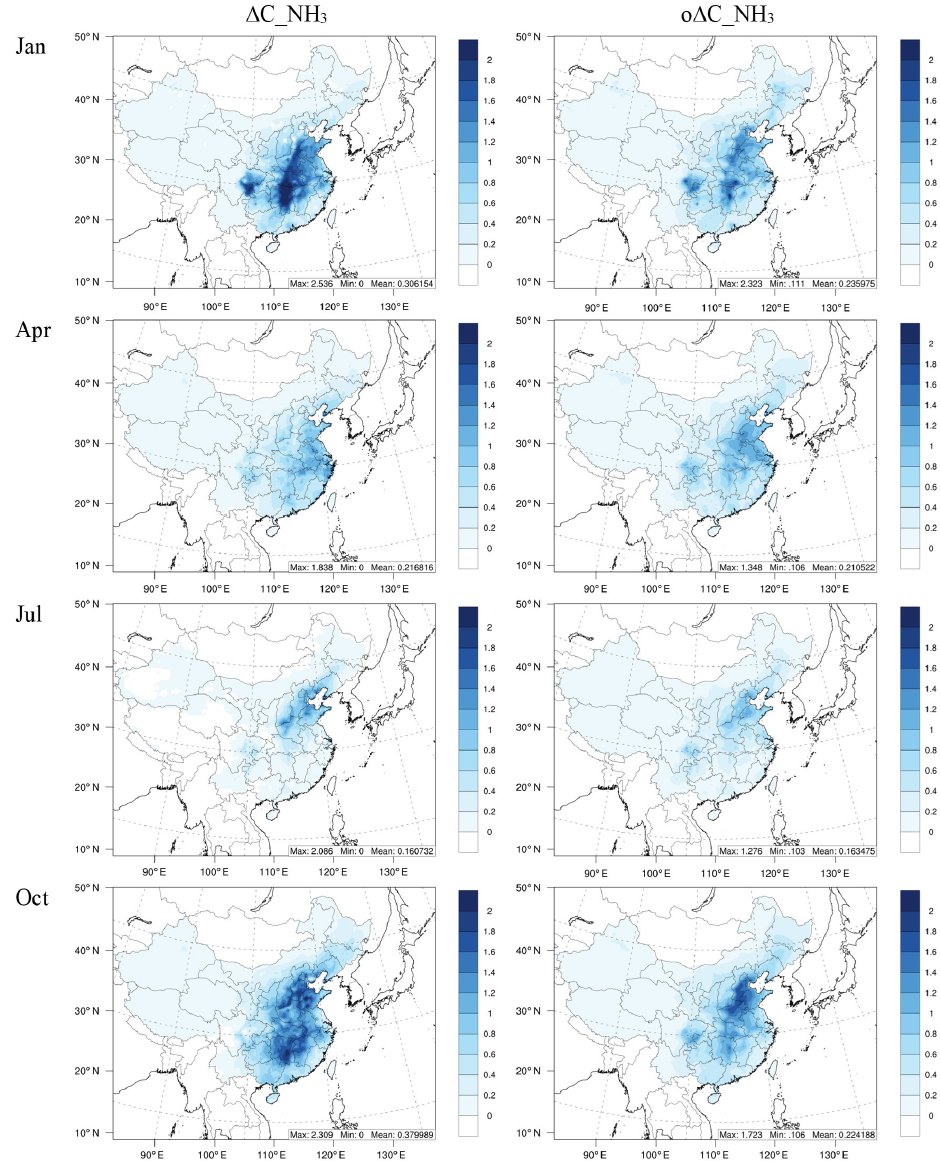
Figure 12. Comparison of the benefit in reducing PM 2 . 5 from simultaneous NH 3 reduction ( (cid:49) C_NH 3 ) with that calculated from concentra- tions (o (cid:49) C_NH 3